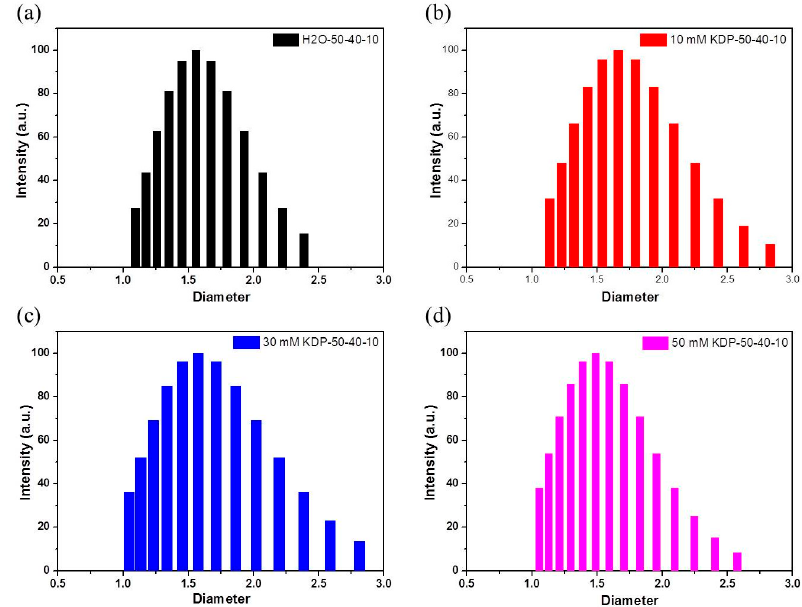
Figure 3. Size distribution of micelles in traditional W/O microemulsion ( a ) and functional KDP aq/O microemulsion with different c KDP ( b – d ).